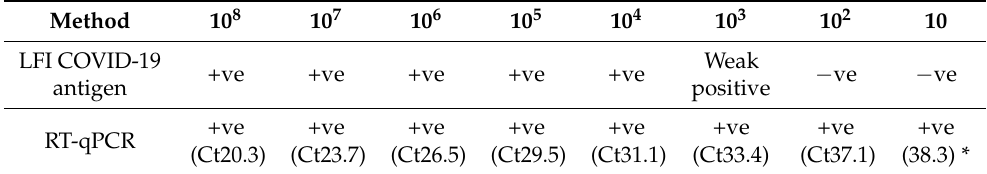
Table 1. Limit of detection (LOD) of SARS-CoV-2 antigens by the developed LFI antigen test, as compared to RT-qPCR using phosphate buffer saline samples spiked with